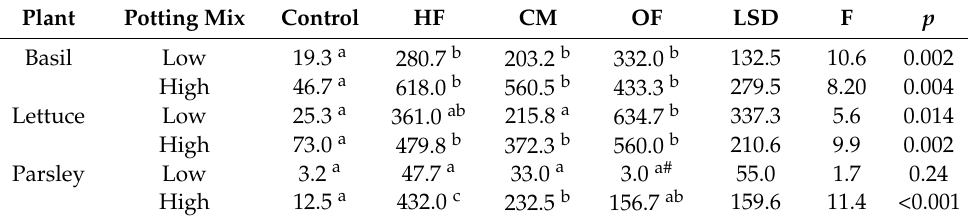
Table 2. Shoot dry weight (mg; mean; n = 4#) of basil, lettuce and parsley seedlings grown in high or low nutrient potting mix and treated with 2 g HexaFrass™ (HF), chicken manure (CM) or organic fertilizer (OF). p values obtained from unbalanced ANOVA; treatments in each row not sharing same letter code are separated at p < 0.05 using LSD. # only one plant survived to harvest in this treatment.